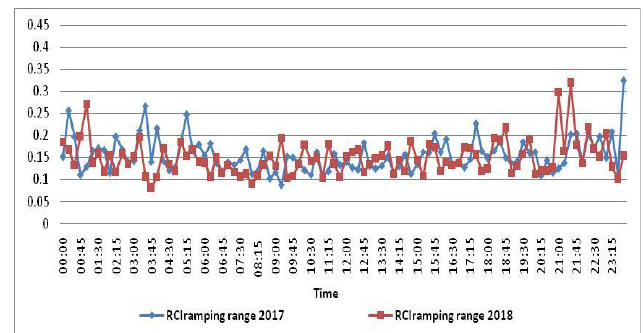
Figure 21. Comparison between RCI for ramping range values of power ramps in 15 min interval at each observation time t for the years 2017 and 2018.